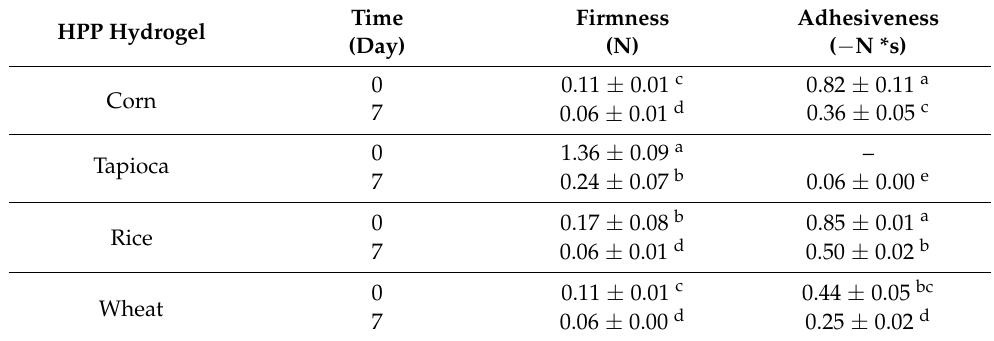
Table 2. Influence of temperature cycling tests on the firmness and adhesiveness of starch-based hydrogels immediately after HPP treatments. Time HPP Hydrogel